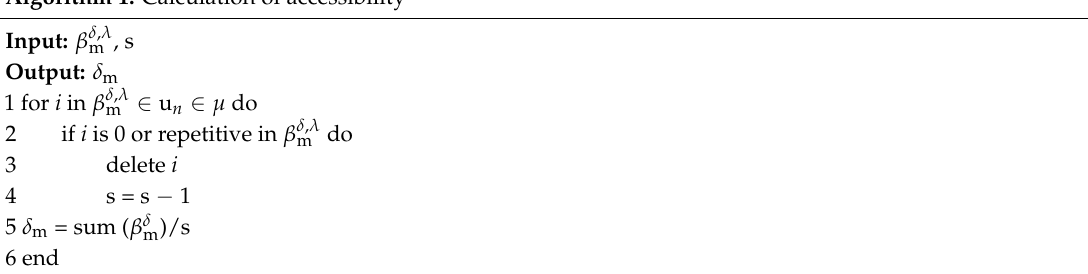
Algorithm 1. Calculation of